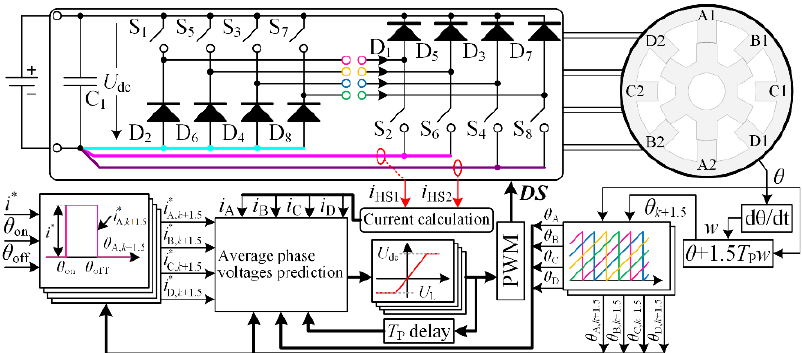
Figure 12. Block diagram of the simulated SRM drive system with the proposed N p /2 sensors-based current detection scheme.